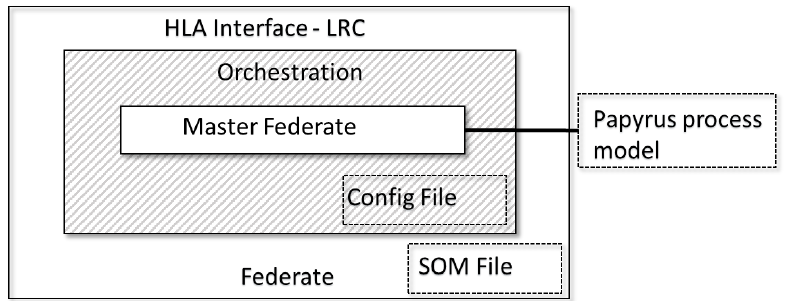
Figure 2. Layered view of a master